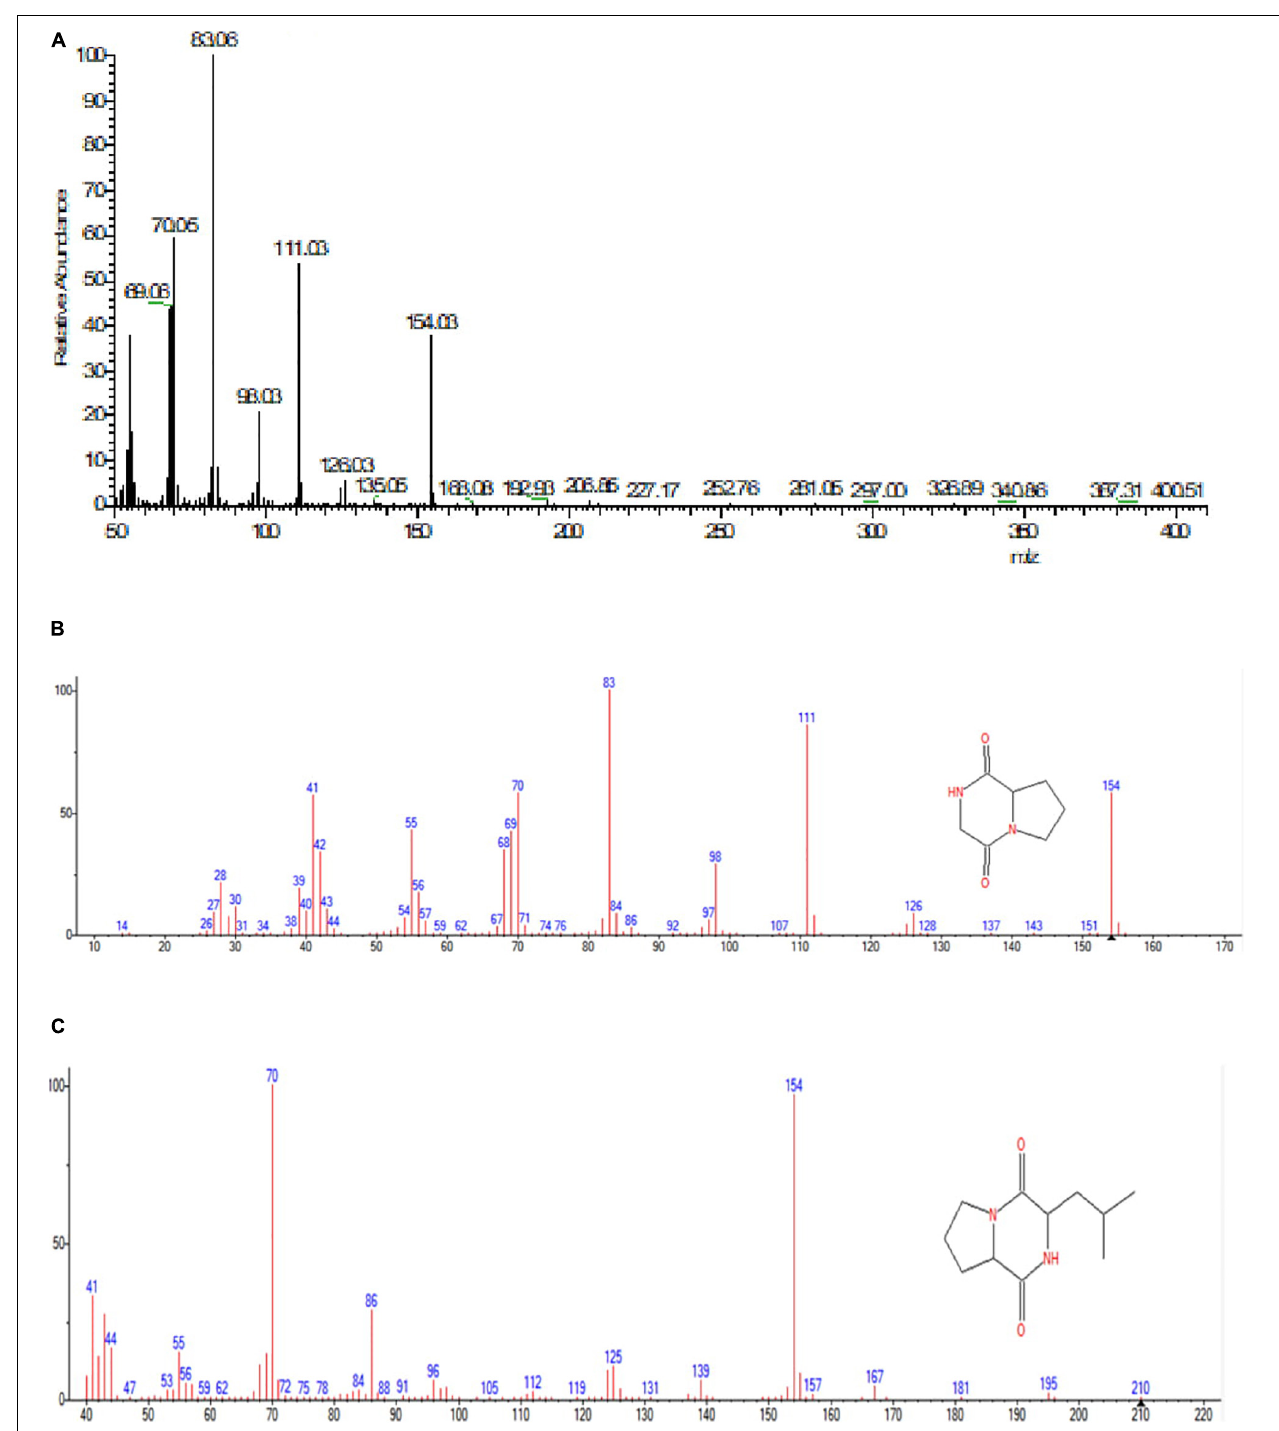
FIGURE 5 | (A) Mass spectral analysis of methanolic crude extract of B. seminalis JRBHU6. (B) Full range spectra of PPDH compound. (C) Full length spectra of PPDHMP compound.